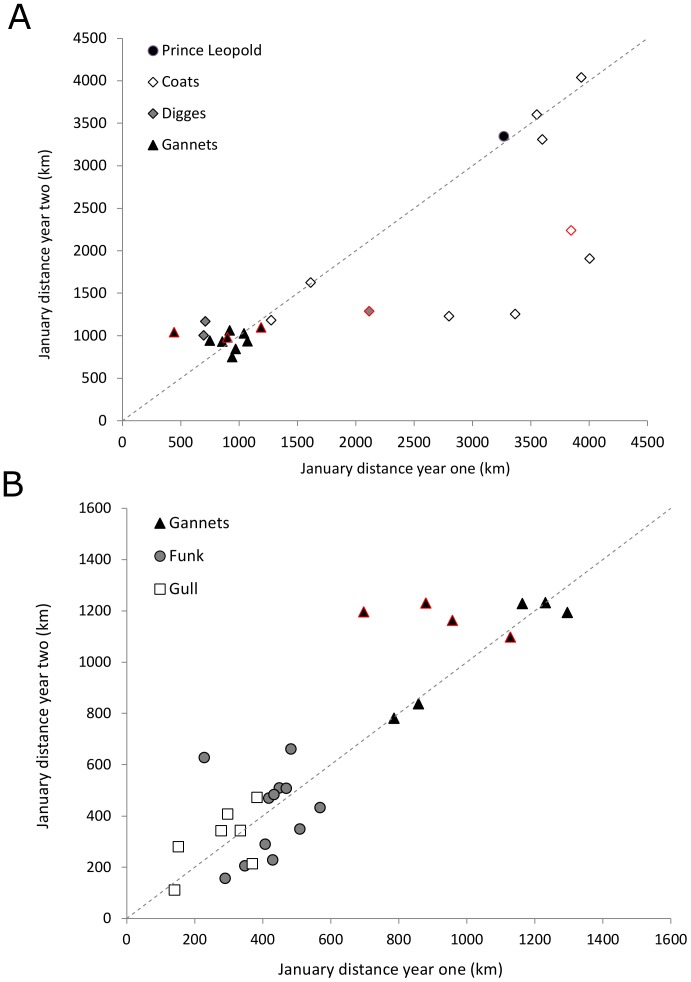
Repeated distances travelled.Relationship of distance travelled (straight line, in km) from the colony to the January centroid in consecutive years (year one vs. year two), for (A) Thick-billed Murres and (B) Common Murres. Dotted line represents the hypothetical 1∶1 relationship if distances are the same in successive years. Markers outlined in red indicate birds that switched regions across years.